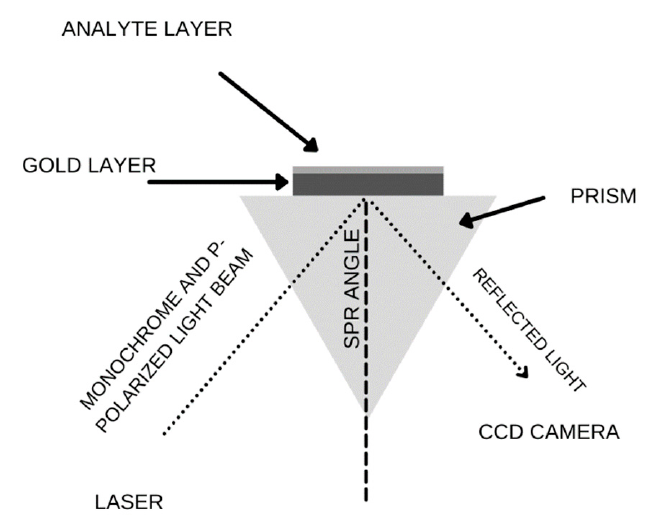
Figure A1. Diagram of the Kretschmann